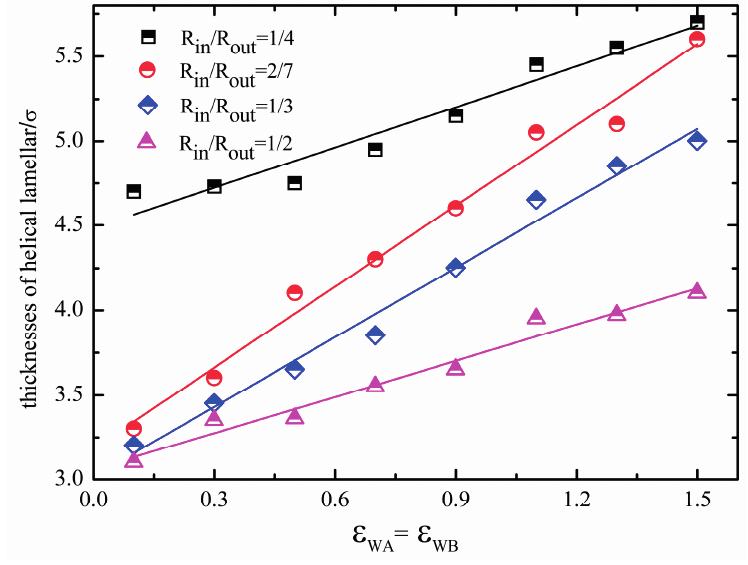
Figure 7. Thickness of helical lamella in morphologies as a function of the interaction strength between nanotubes and block